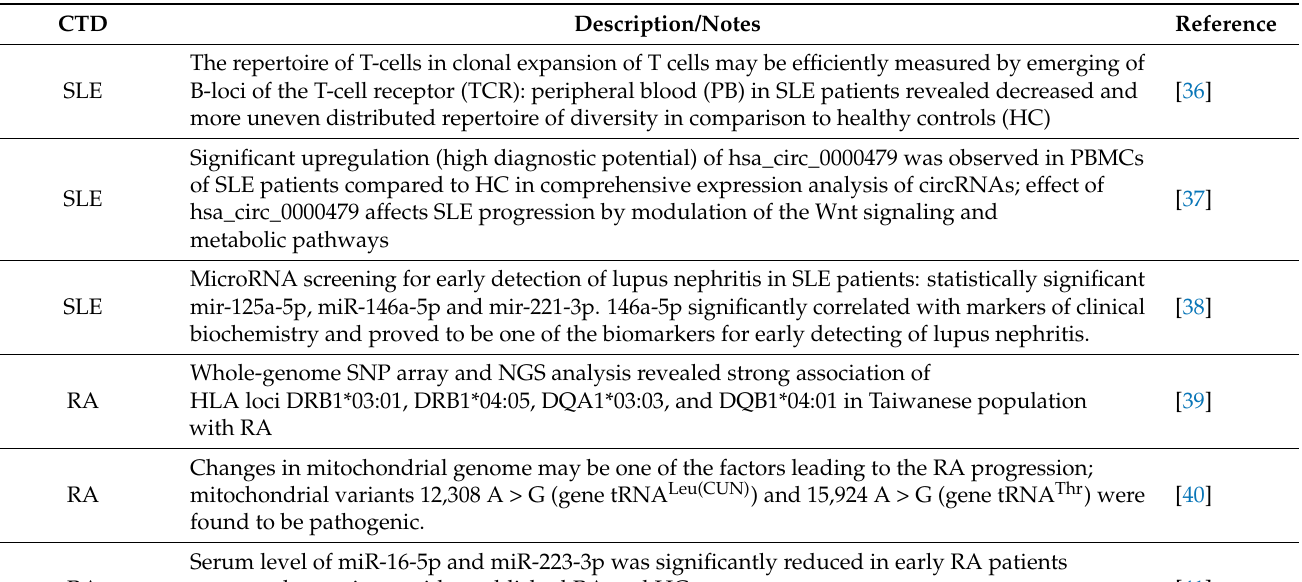
Table 1. Studies on autoimmune connective diseases conducted by NGS in last 5 years.